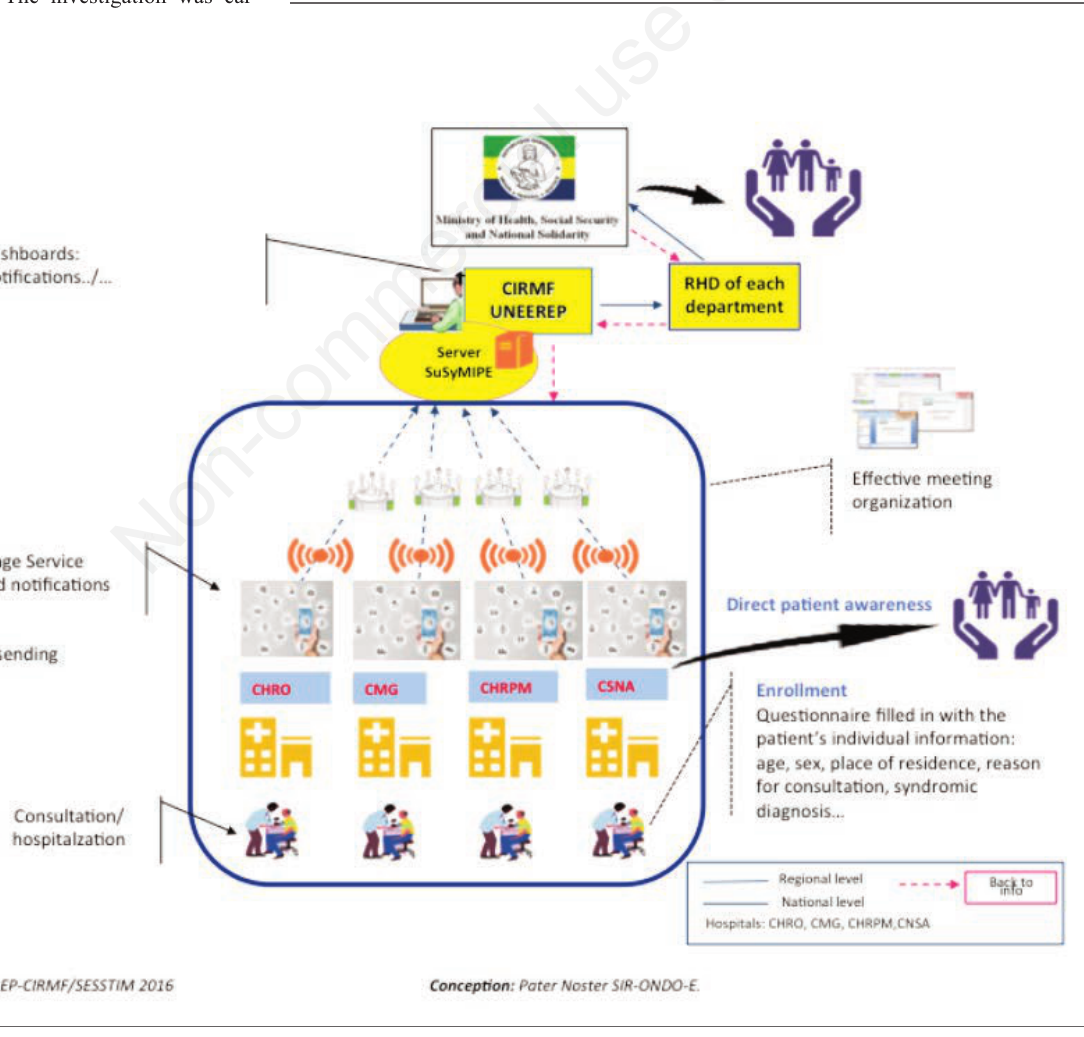
Figure 2. Architecture of the monitoring network for the syndromic surveillance of infectious diseases and potential